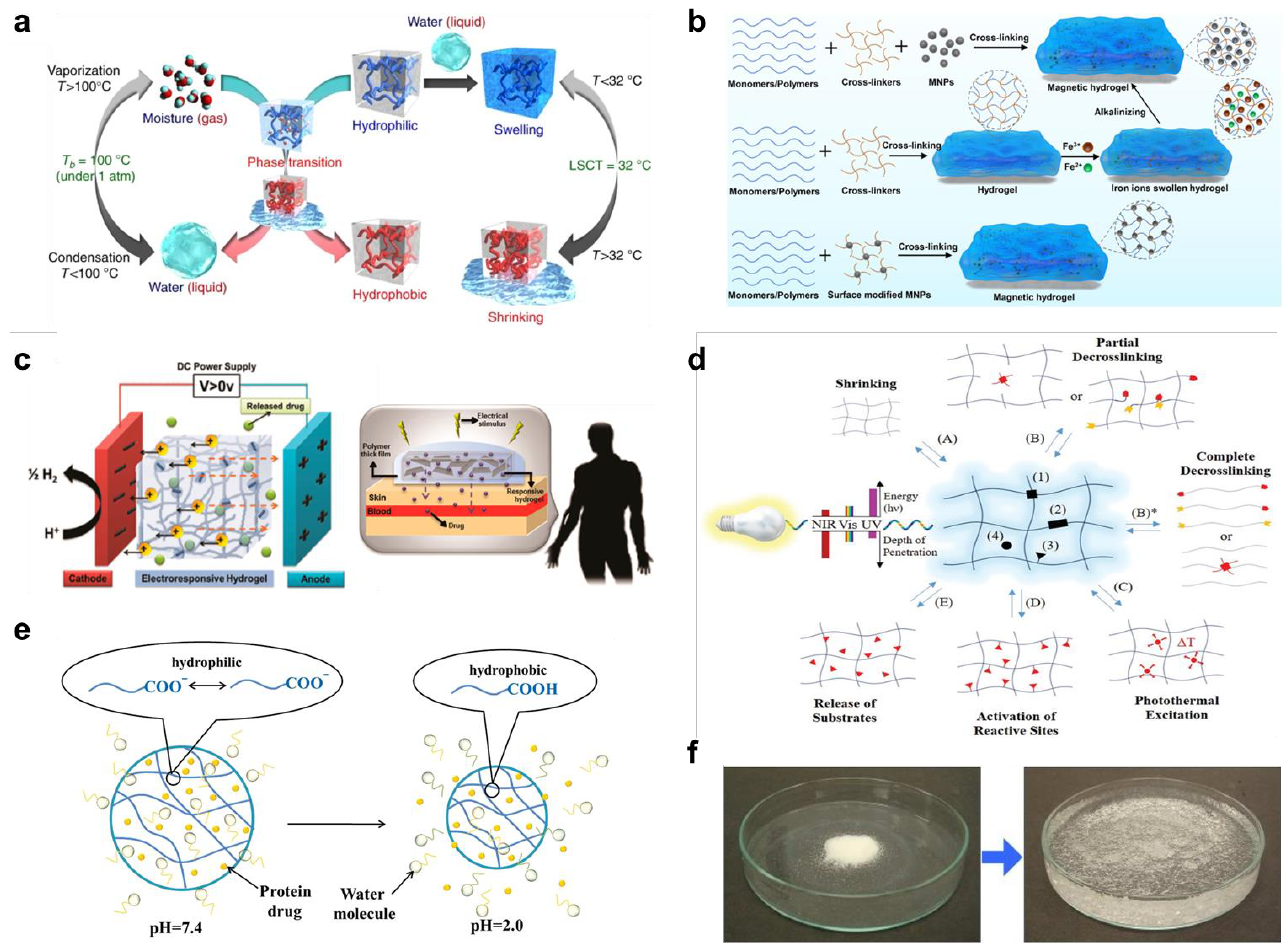
Figure 3. ( a ) Schematic diagram of thermal-responsive hydrogels. Reproduced with permission from [46] . Copyright © 2018 Springer Nature. ( b ) The preparation methods for magnetic-responsive hydrogels. Reproduced with permission from [40] . Copyright © 2021 Elsevier. ( c ) The mechanisms for electro-induced gel deswelling for drug delivery. Adapted with permission from [47] . Copyright © 2015 American Chemical Society. ( d ) Molecular architecture and responses of a photo-responsive hydrogel. Reproduced with permission from [48] . Copyright © 2019 Springer Nature. ( e ) Schematic illustration of pH-responsive hydrogels. Reproduced with permission from [49] . Copyright © 2019 Progress in Chemistry. ( f ) Dry SAP powder and swollen SAP hydrogel. Adapted with permission from [50] . Copyright © 2016 Elsevier.